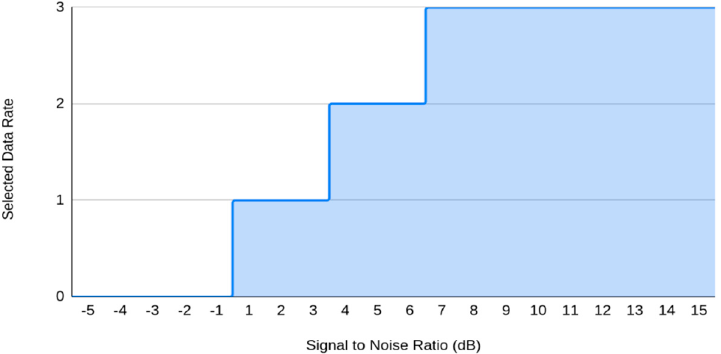
Figure 17. Selected data rate according to the SNR value; 1, 2 and 3 represent 2400 bps, 4800 bps and 9600 bps, respectively.